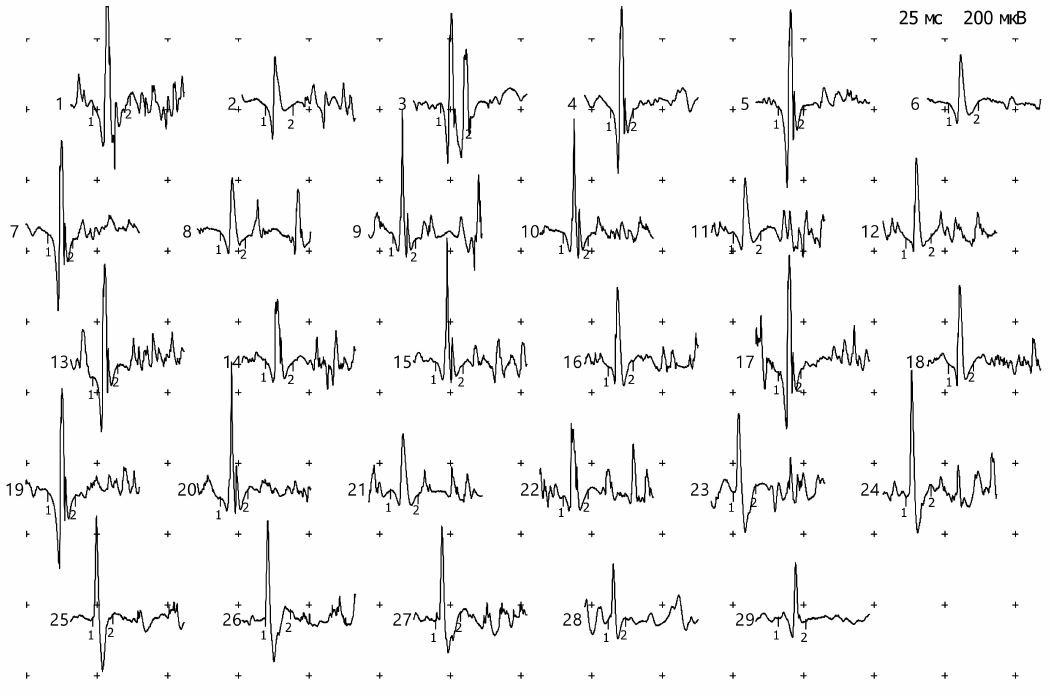
Figure 4. Motor unit potentials (MUPs) (m. tibialis anterior dex, peroneus, L4 L5 s1). Table 2. Motor unit potentials (MUPs) (m. tibialis anterior dex, peroneus, L4 L5 s1). Duration of